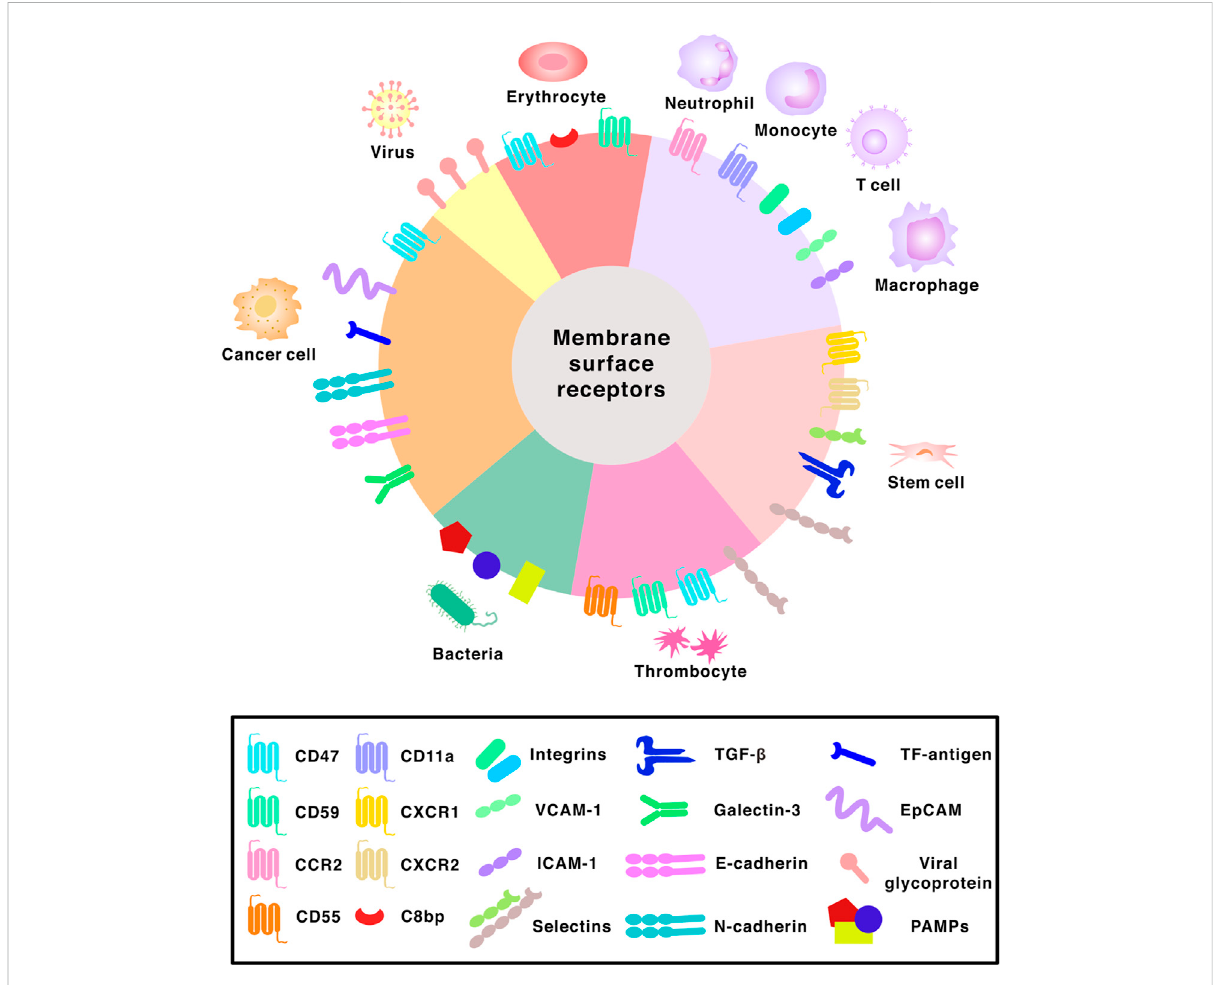
FIGURE 3 Surface receptors found on different membranes. Abbreviations: CCR2, C-C chemokine receptor 2; CXCR1, C-X-C chemokine receptor 1; CXCR2, C-X-C chemokine receptor 2; C8bp, C8 binding protein; VCAM-1, vascular cell adhesion molecule-1; ICAM-1, intercellular adhesion molecule-1;TGF- β ,transforminggrowthfactorbeta;TF-antigen,Thomsen-Friedenreichantigen;EpCAM,epithelialcelladhesionmolecule;PAMPs, pathogen associated molecular